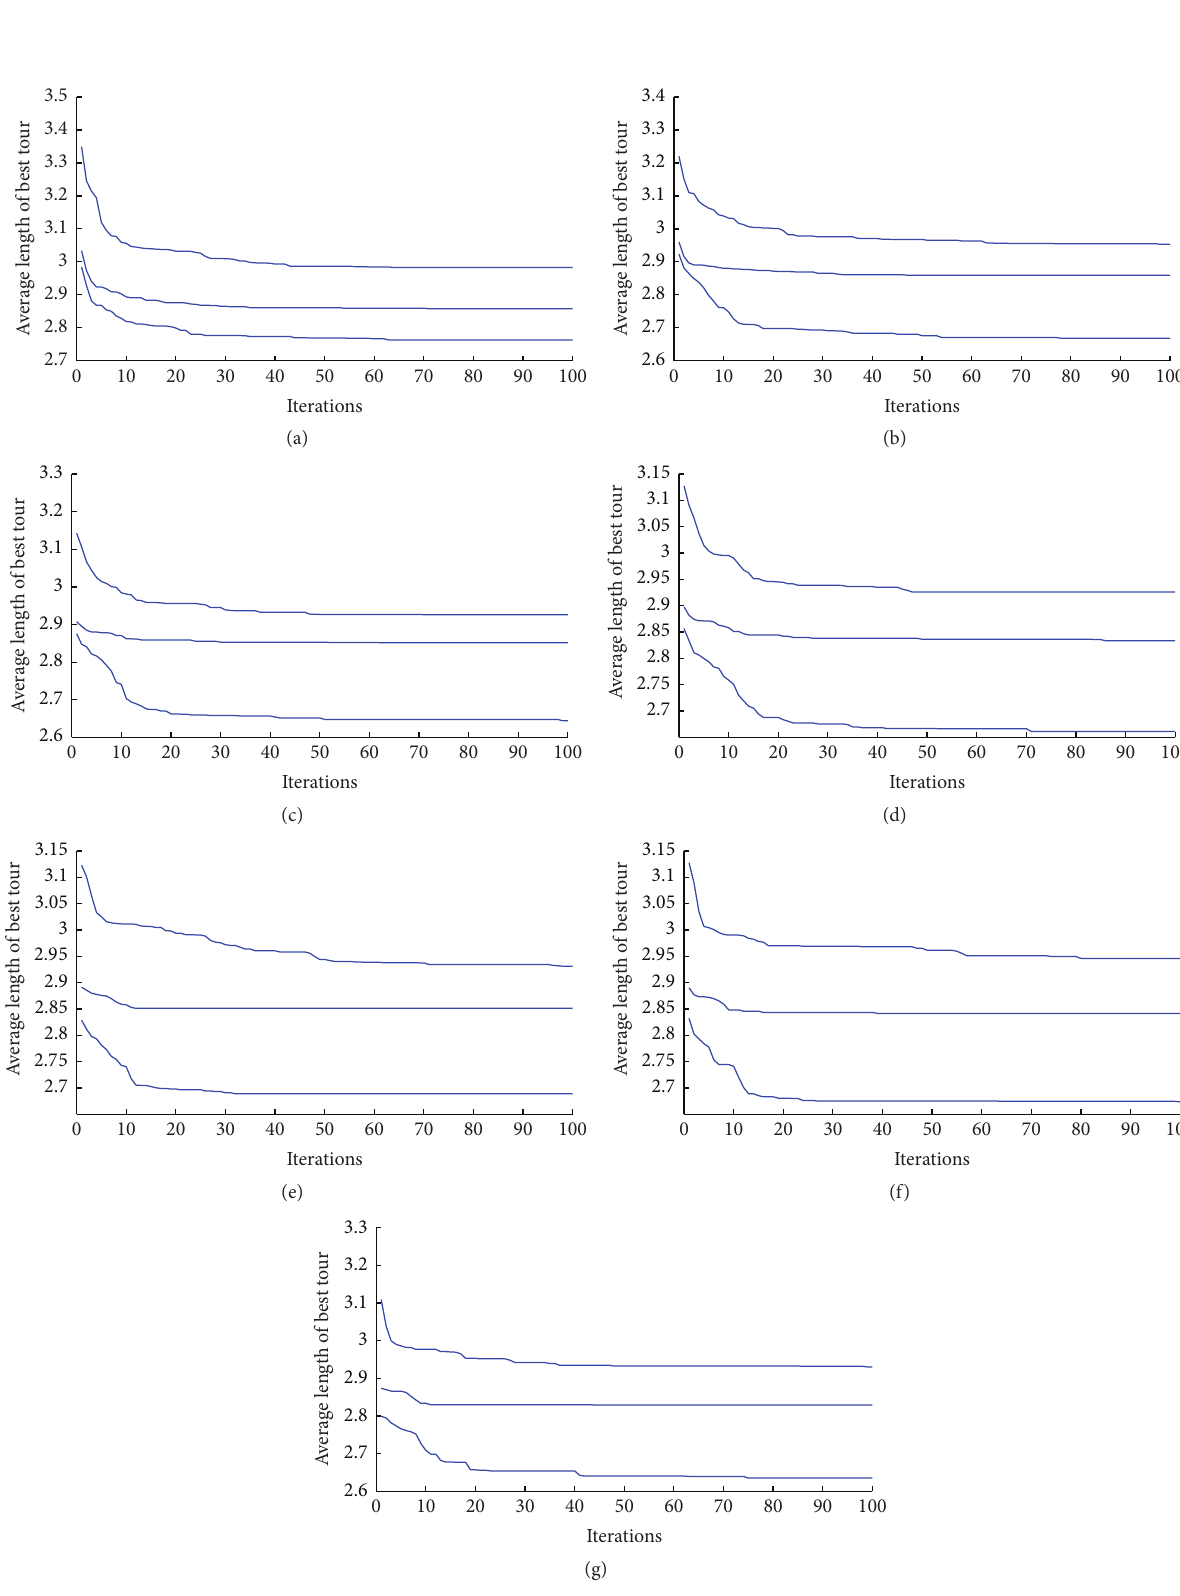
Figure 6: Results obtained by ASClass algorithm obtained on Iris dataset (a) 𝑚 = 5 ; (b) 𝑚 = 10 ; (c) 𝑚 = 20 ; (d) 𝑚 = 30 ; (e) 𝑚 = 40 ; (f) 𝑚 = 50 ; (g) 𝑚 = 100